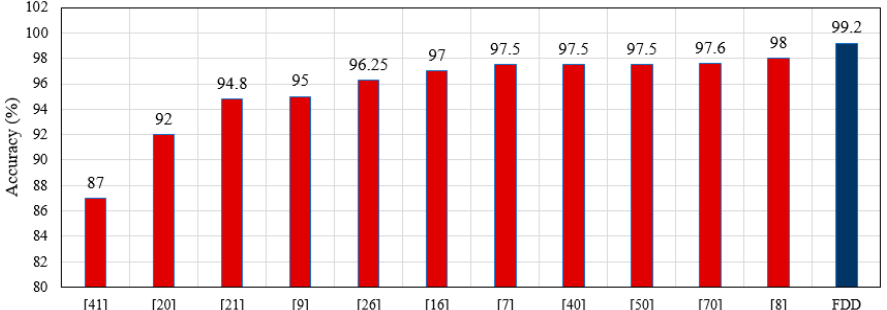
Figure 18. Comparison of the accuracy of the FDD with those of previous works.